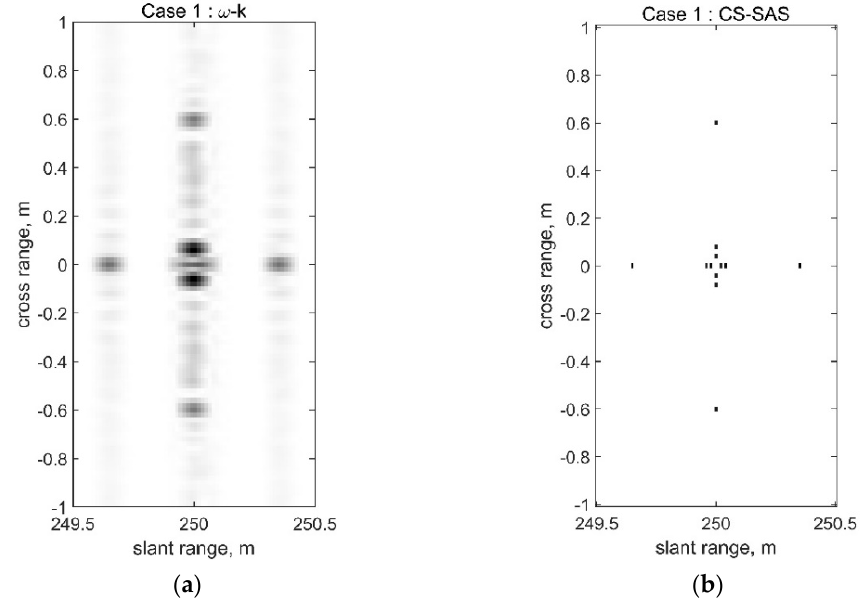
Figure 5. Simulation results for Case 1 for single sensor: ( a ) result for the ω -k algorithm; ( b ) result for the CS-SAS algorithm for single sensor.